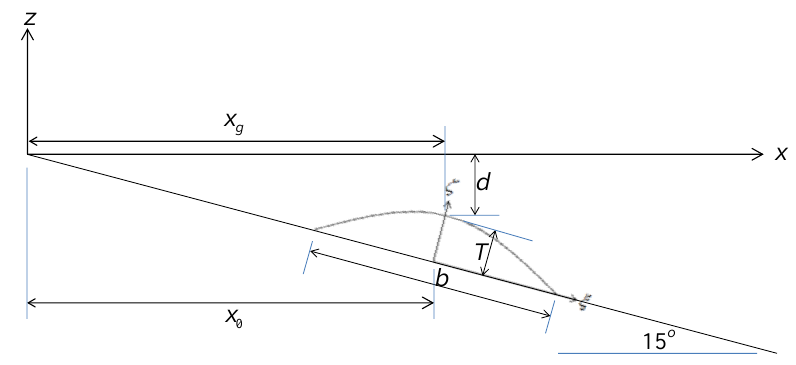
Figure 4. The layout of the experiment in Enet and Grilli [6].